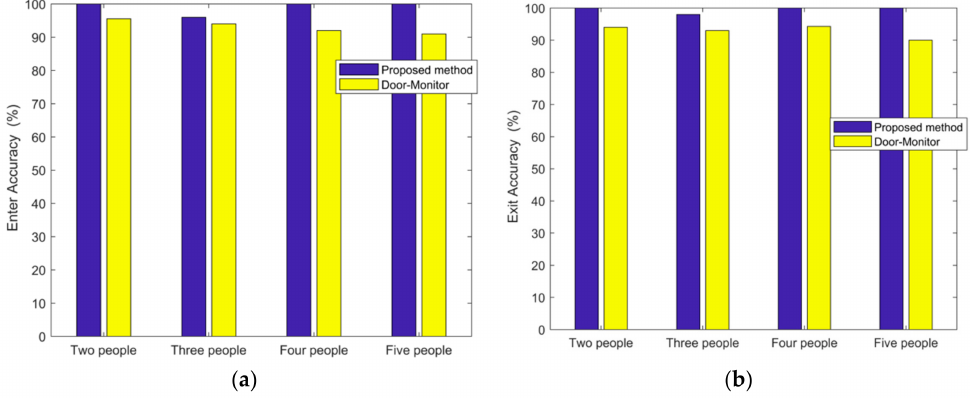
Figure 12. Accuracy of passing direction detection at small office room. ( a ) Enter. ( b )